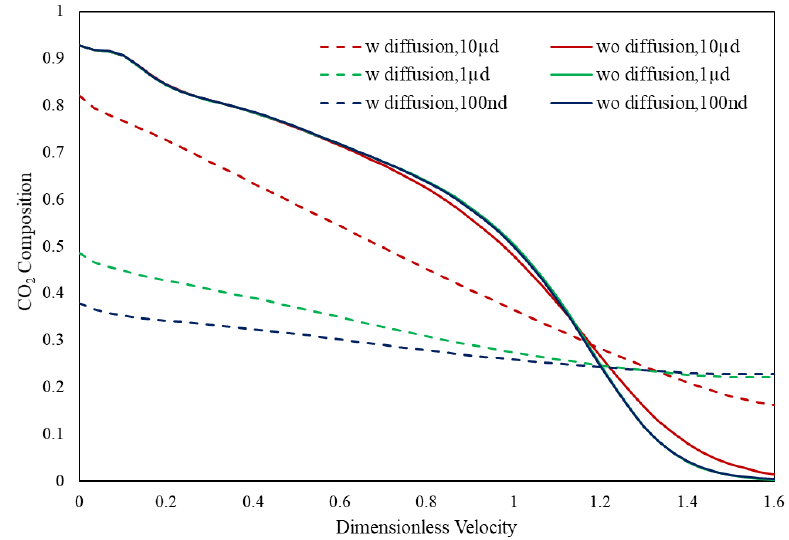
Figure 23. CO 2 composition versus dimensionless velocity with and without diffusion for different permeability, Bakken, heterogeneous pore size reservoir.